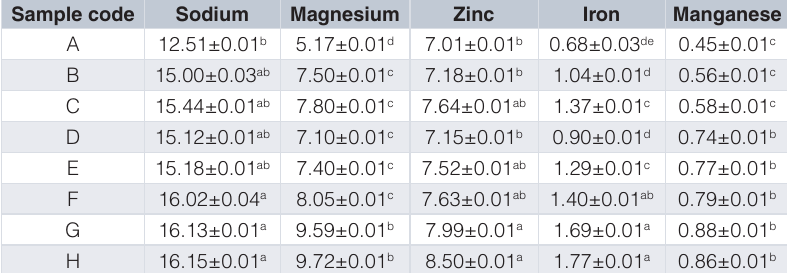
Table 4. Mineral Content (mg/100g) of Ogi (sorghum) flour with Garlic and